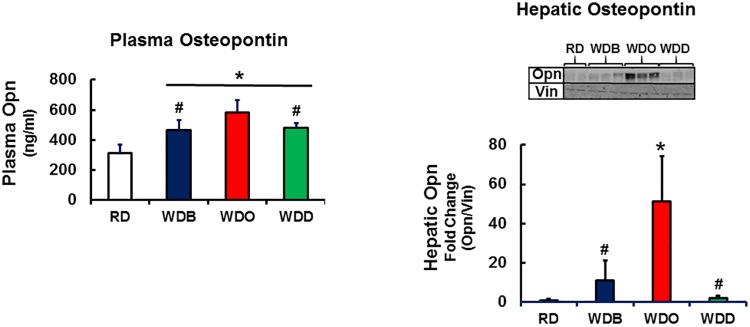
Quantitation of plasma and hepatic osteopontin (Opn).Mouse plasma osteopontin levels were quantified by ELISA (R & D Systems). Results are expressed as Opn, ng/ml of plasma, N = 4–7; mean + SD; *, p<0.05 versus the RD group; #, p<0.05 versus the WDO group; one-way ANOVA. Hepatic Opn was quantified by immunoblot analysis of whole cell hepatic extracts as described previously. The mouse antibodies use in the analysis were anti-Opn (R & D Systems) and vinculin (Millipore); vinculin (Vin) was a loading control. Results were quantified by Licor Odyssey [40, 60] and expressed as abundance of Opn/Vin. Extracts from 3 separate livers in each group were examined by immunoblot analysis. Results are expressed as mean + SD; *, p<0.05 versus the RD group; #, p<0.05 versus the WDO group; one-way ANOVA.